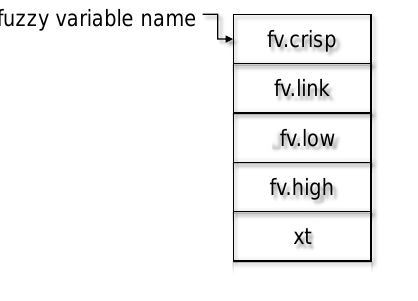
on depl oyed nodes provided that the symbolic progr am is placed betw een tell: and :tell as indica ted in Figure 3.